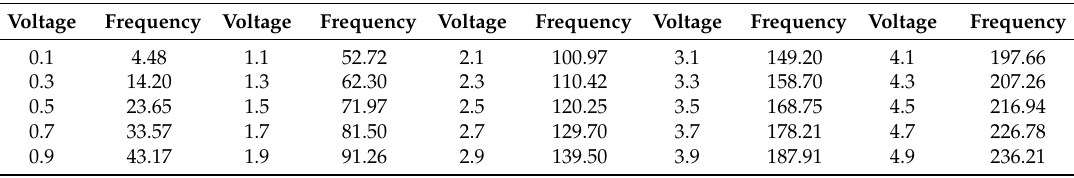
Table 2. Calibration table of VFC (Voltage: V; Frequency: